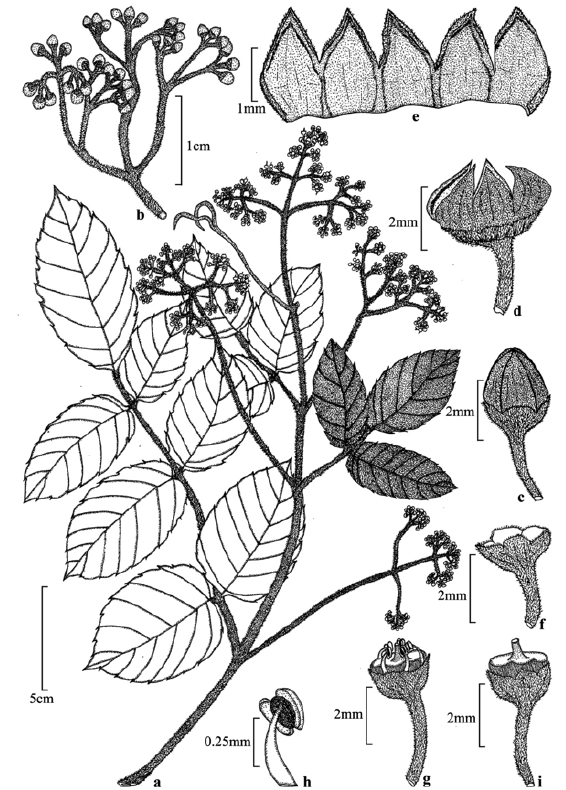
Figure 4. Ampelopsis rubifolia (Wall.) Planch.: a—flowering twig | b—inflorescence | c—bud | d—floret | e—corolla (adaxial view) | f—calyx | g—androecium | h—stamen |